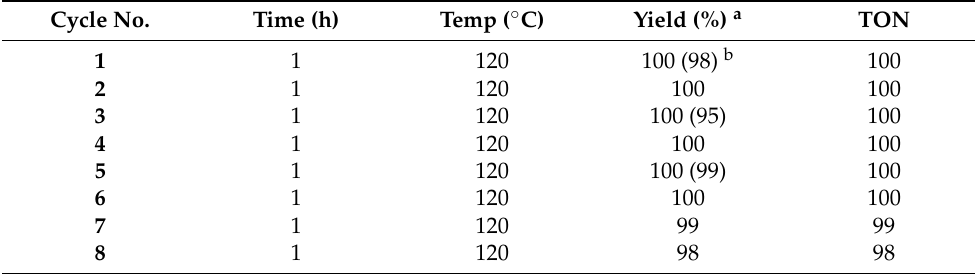
Table 2. Recycling results of 2a -catalyzed Stille reaction of 4-cyanoiodobenzene ( 5 ) and vinyl trib- utyltin ( 3 ) under the thermomorphic